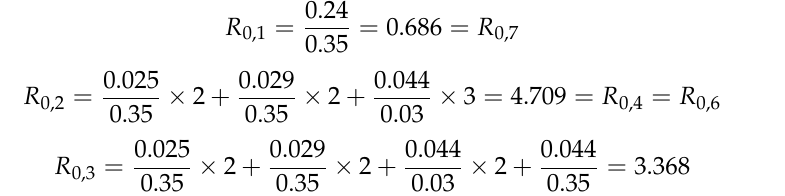
Figure 10. Calculation diagram of the average thermal resistance. The average heat transfer coefficient of the AASCCIB was obtained using Formulas (51) to